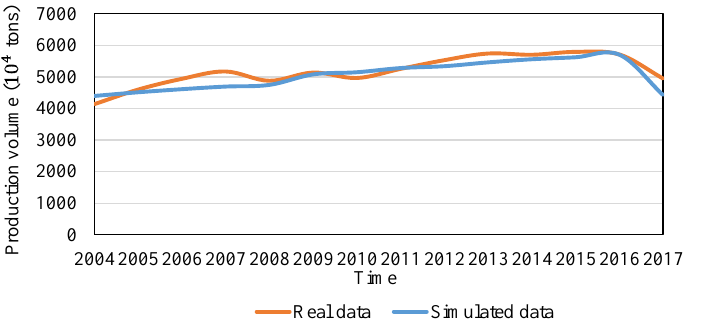
Figure 14. Comparison of the production volume of synthetic ammonia with real data and simulated data.